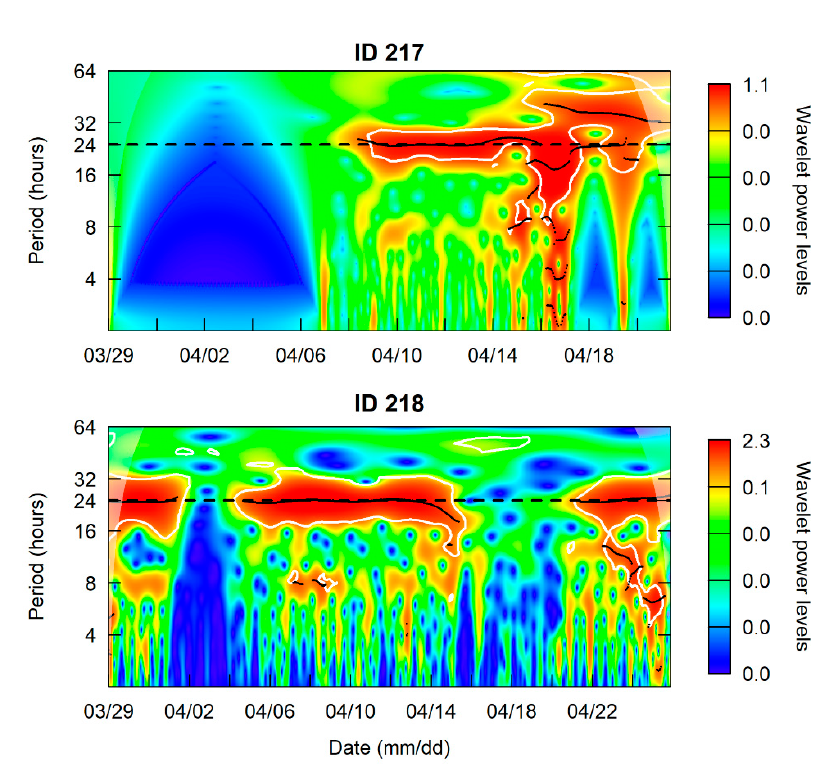
Figure 6. Effects of diel phase, temperature, water level, and river discharge on common carp depth. A smoothing (gam) curve with a span width of 0.5 was added for visual interpretation.